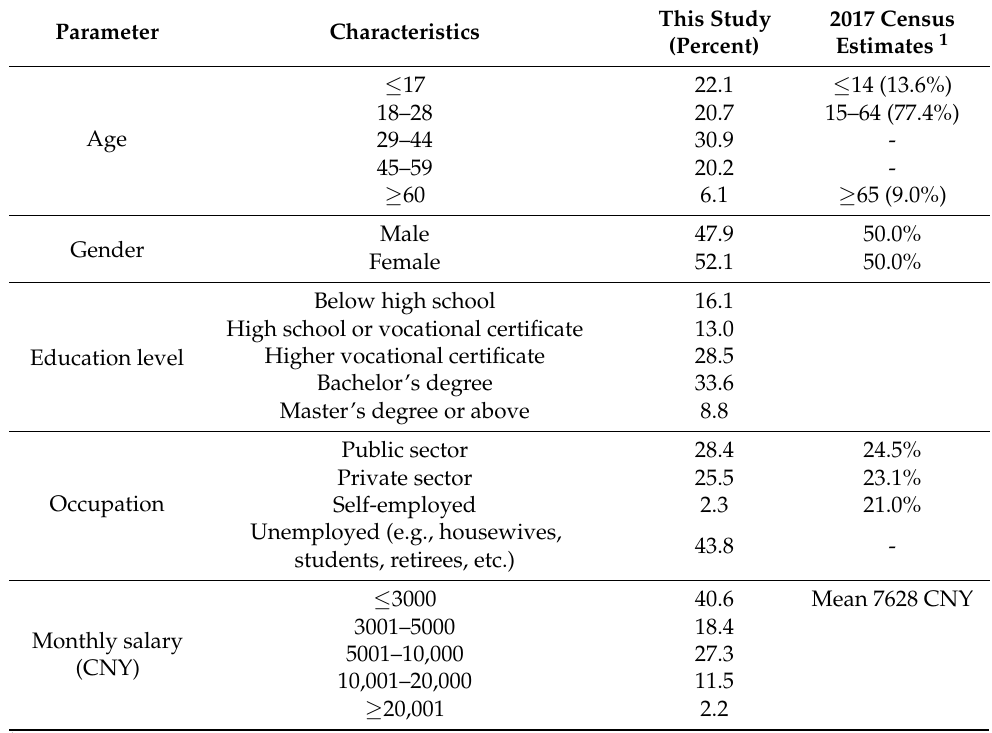
Table 3. Characteristics of Changsha respondents (N =